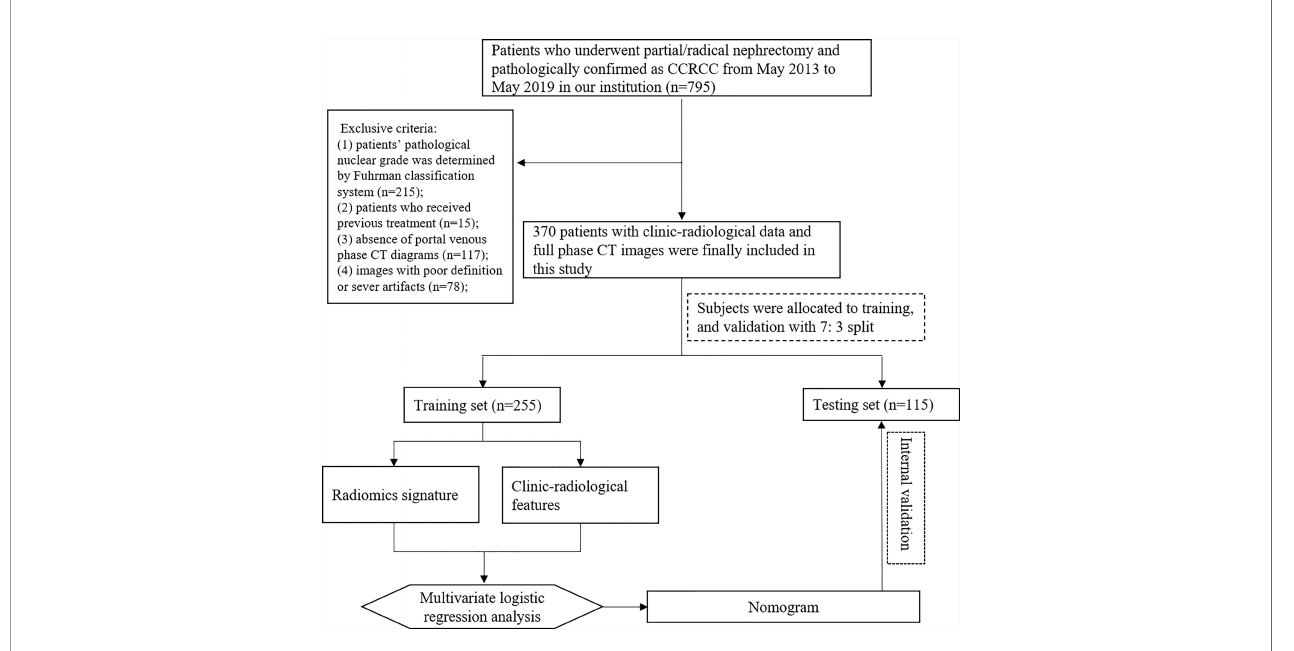
FIGURE 1 | Flowchart of recruiting study population and model